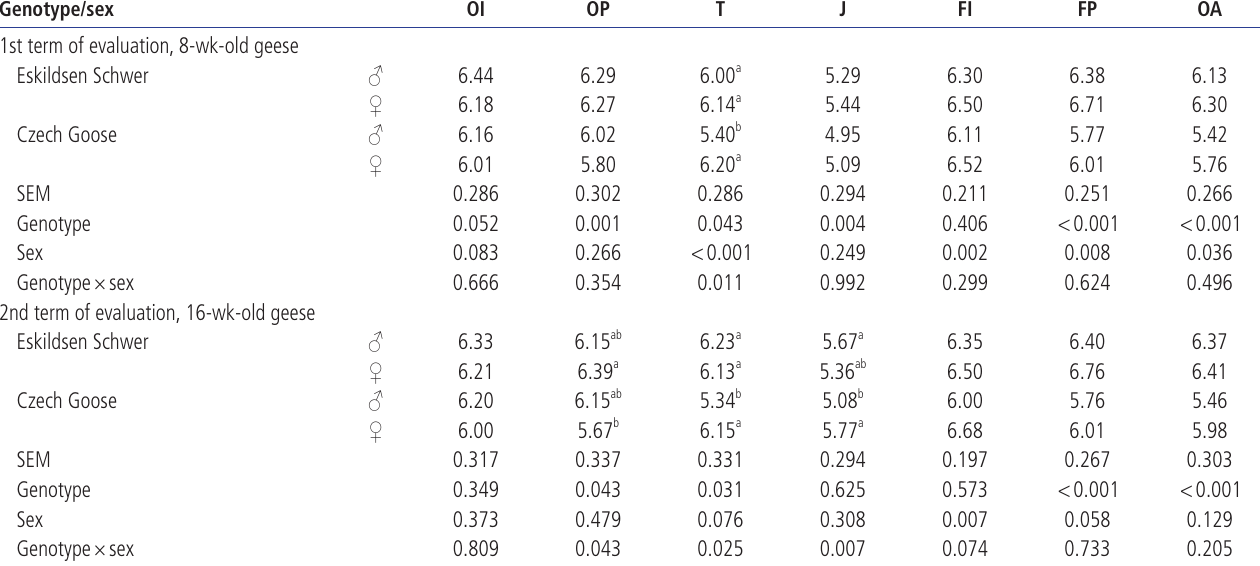
Table 5. Meat sensory attributes in geese at the age of 8 and 16 wk depending on genotype and sex Genotype/sex OI